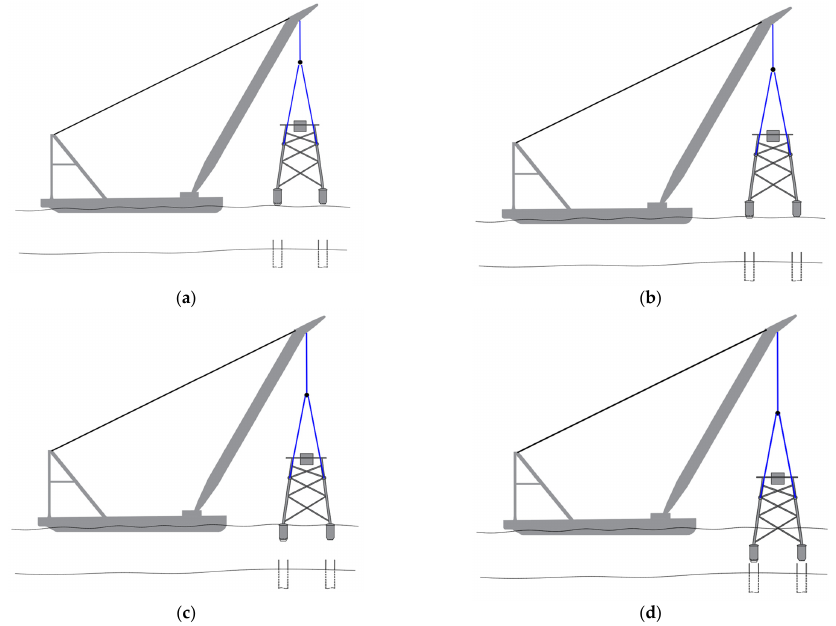
Figure 10. Vertical positions of the jacket. ( a ) JL1-Z1; ( b ) JL1-Z2; ( c ) JL1-Z3; ( d ) JL1-Z4.